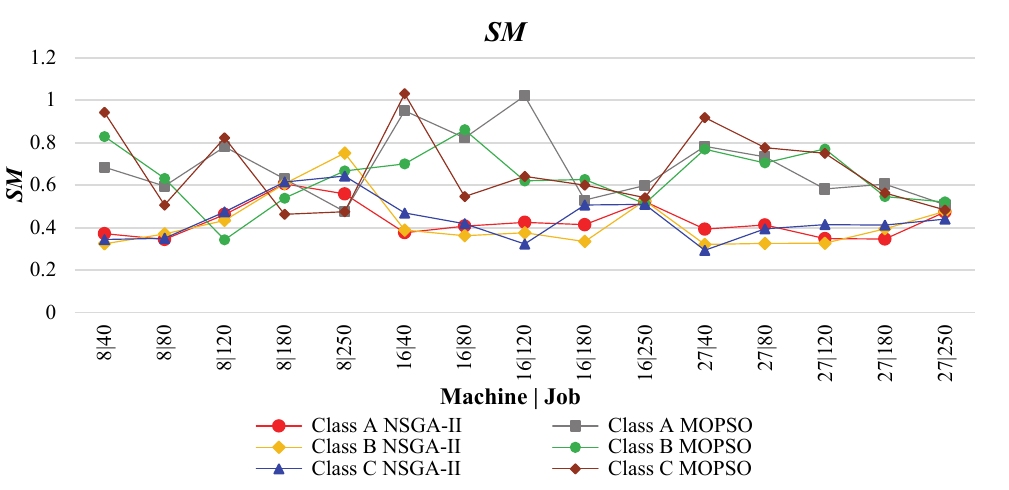
Fig. 16 SM criterion for the two algorithms in the medium and large scale sample problems